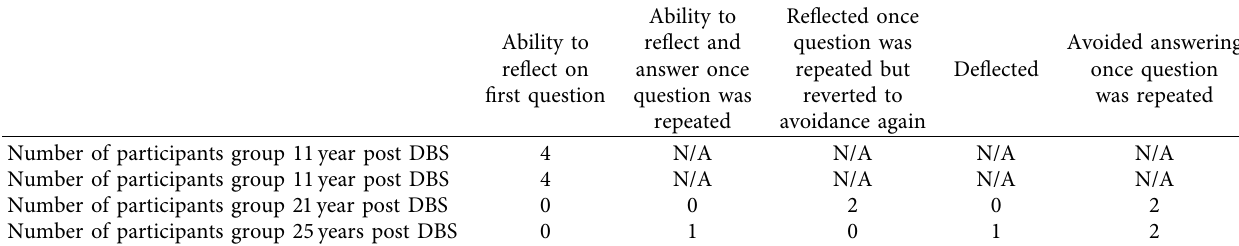
Table 5: Strategies used by participants answering frst